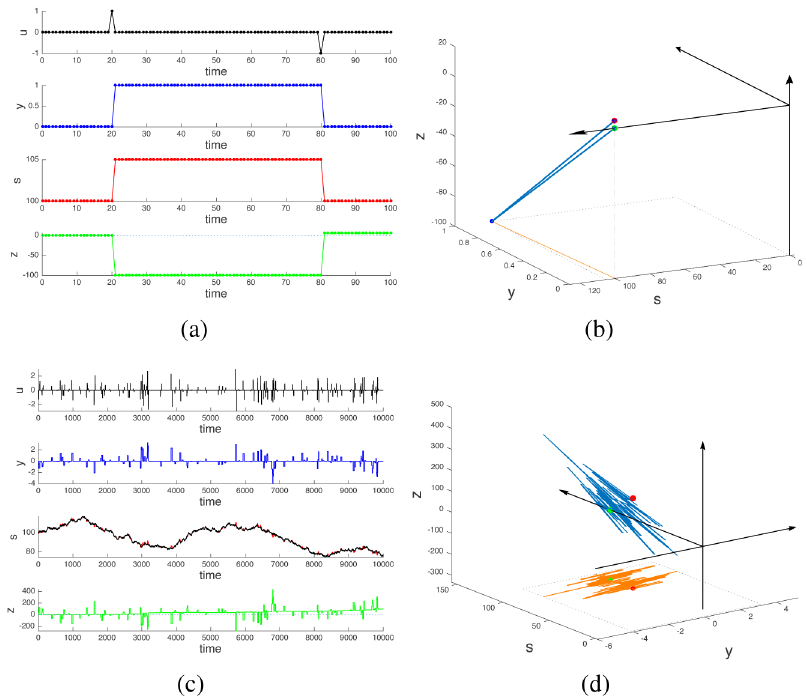
Fig 2. Effect of cyclic trading operations. Panel (a): time profiles of the variables for a single buy-then-sell cycle. Panel (b): corresponding shape and phase space profiles. At time t b = 20 the trader buys a unit of stock. The stock quote s increases consequently because of the price impact of the operation, while the cash balance z becomes negative. At time t s = 80 the stock is sold and the stock quote returns to the level it had at t = 0. However, the cash balance z becomes positive because the stock is sold at a price higher than it was bought. The shape trajectory of the variables ( y , s ) is cyclic and has zero area (orange curve in panel (b)). The phase variable z experiences a net displacement because of the cycle, i.e., a geometric phase is produced (blue curve in panel (b); the starting point is the green dot and the final point is the red dot). Panels (c) and (d): When the stock quote is allowed to drift because of the operations of other traders, then periodic operations of a trader no longer result in cyclic trajectories in shape space ( y , s ). However a geometric phase in the z variable is still present and keeps building up whenever the trader completes a cycle of operations. In panel (c), the plot for s shows in black the stock quote in absence of trading cycles, and in red the deviations due to these trading cycles, visible only during the intervals in which stocks are hold (or shorted, for sell-then-buy cycles). Such red deviations are a direct consequence of our price impact assumption, and induce the accumulation of positive cash balance (green trace in